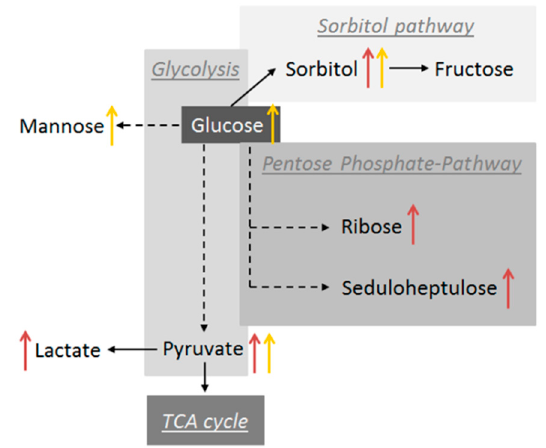
Figure 3. Schematic diagram of detected biochemicals in glycolysis and pentose phosphate pathway. Changes of metabolite concentration are indicated by arrows ( ↑ ), in yellow for diabetic plasma samples and in red for blastocoel fluid from 6 day old blastocysts of diabetic rabbit.